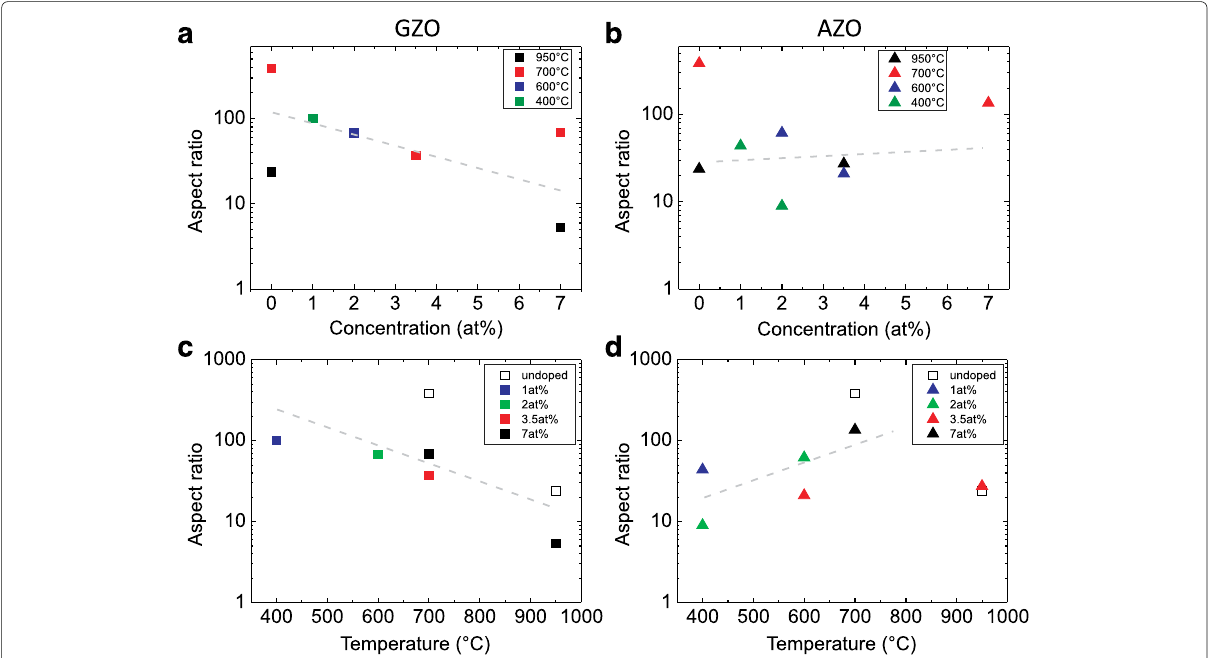
Fig. 3 The aspect ratio of the NWs as a function of the doping concentration ( a , b ) and growth temperature ( c , d ) for the Ga-doped ( a , c ) and Al-doped seed layers ( b , d ). The graydashedlines are guides for the